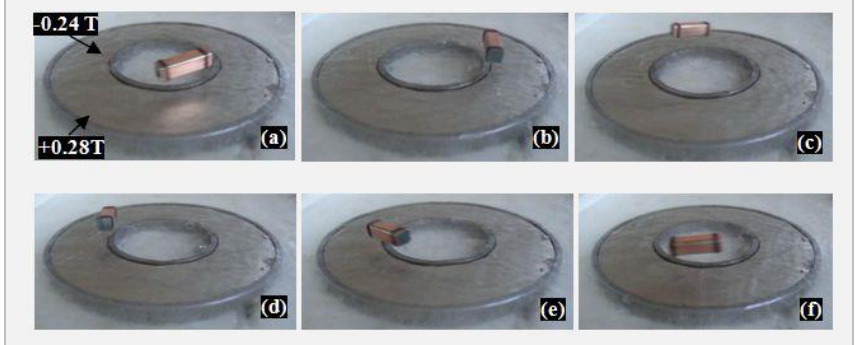
Figure 8. Laboratory scale tests with the PMG-system of a circular type ( a – f —consecutive video frames of the HTSC-Sabot counterclock-wise moving).